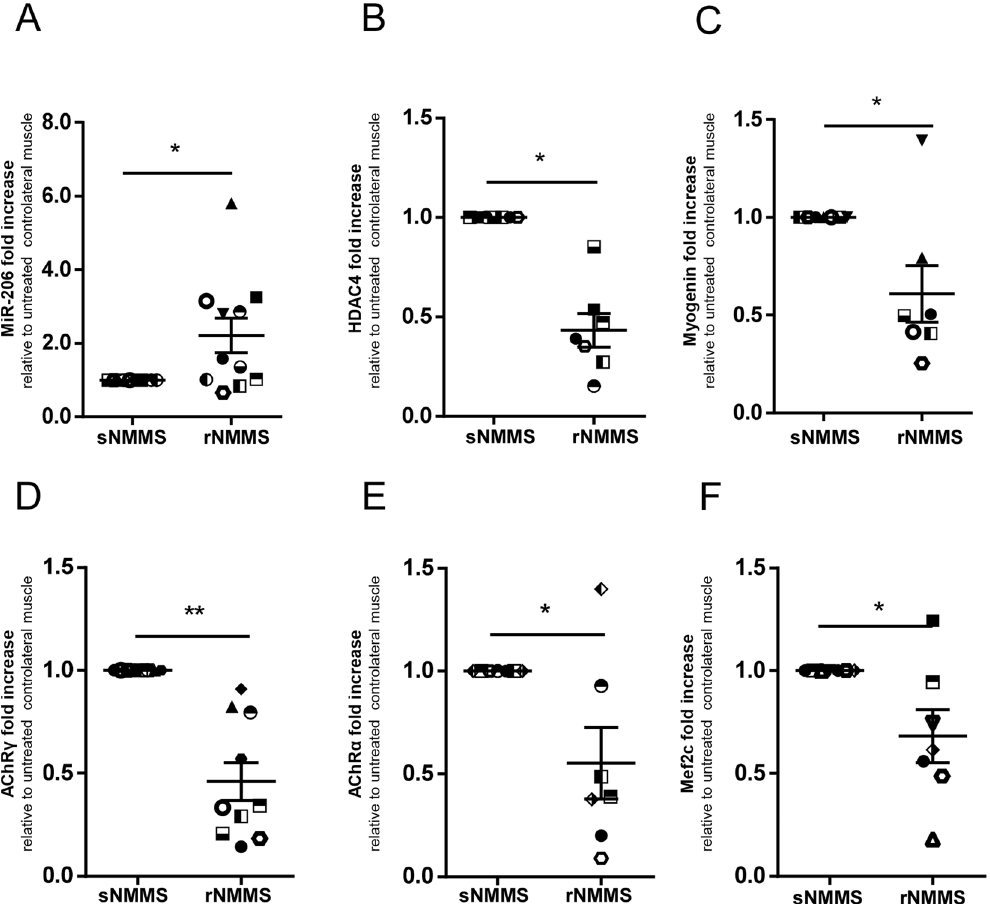
Figure 7. NMMS treatment stabilizes the neuromuscular end plate and preserves muscle fiber composition during disease progression. ( A ) Real-time PCR analysis of MiR-206, ( B ) HDAC4, ( C ) Myogenin, ( D ) AChR γ , ( E ) AChR α , ( F ) Mef2c transcripts in rNMMS- and sNMMS-treated samples ( * p < 0.05 ** p < 0.01. Data represent mean ±